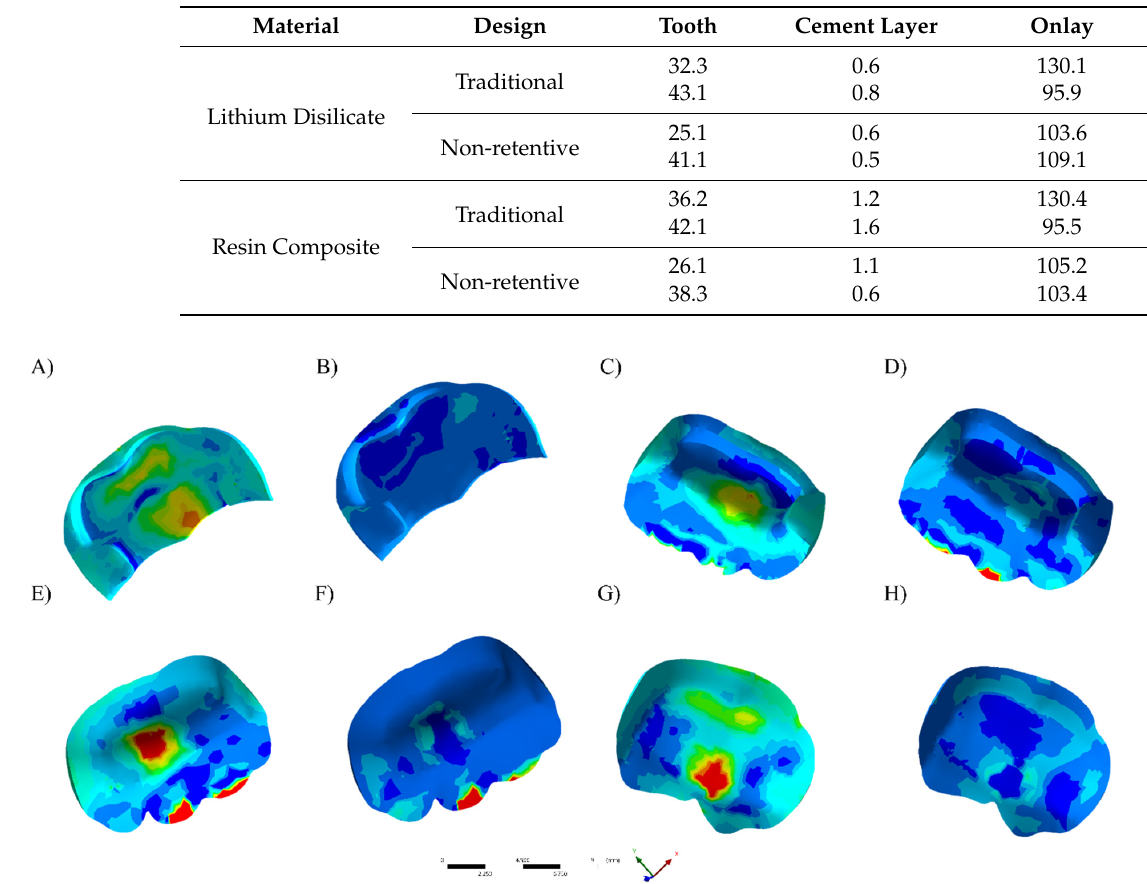
Figure 2. Maximum principal stress distribution in the restoration’s intaglio surface. ( A ) LD TFC. ( B ) RC TFC. ( C ) LD TNFC. ( D ) RC TNFC. ( E ) LD NFC. ( F ) RC NFC. ( G ) LD NNFC. ( H ) RC NNFC.